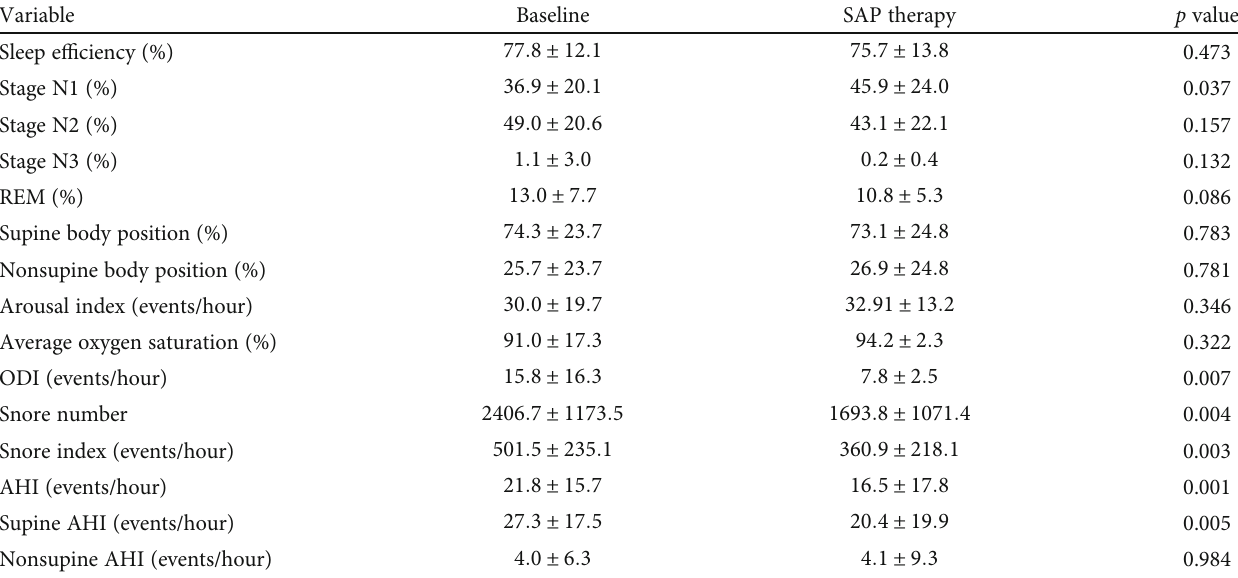
Table 2: Polysomnographic variables of baseline and SAP therapy of 30 patients.